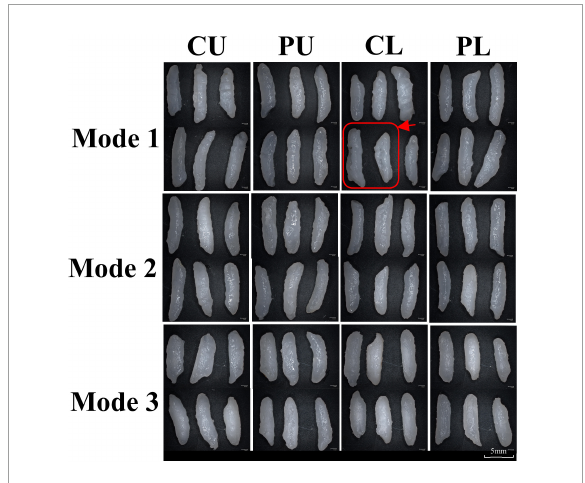
FIGURE3 Morphological changes in rice under different heating modes. The red line marked damaged rice. CU, central upper layer; PU, peripheral upper layer; CL, central lower layer; and PL, peripheral lower layer.